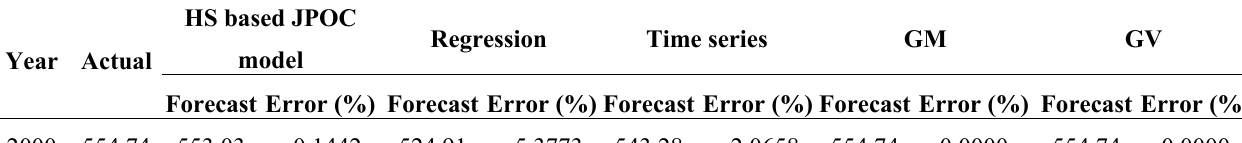
Table 6. Forecasting results of the HS-based JPOC model and the other four single models for India